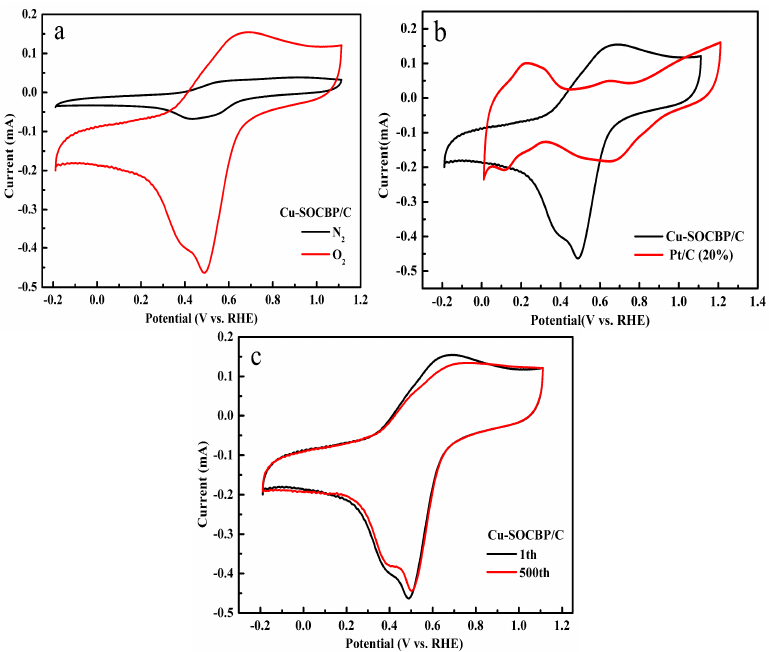
Figure 5. Cyclic voltammetry (CV) of Cu ‐ SOCBP/C in phosphate buffer solution (PBS) saturated once with N 2 and once with O 2 ( a ); CV of Cu ‐ SOCBP/C and Pt/C in PBS saturated with O 2 ( b ); and CV of Cu ‐ SOCBP/C in PBS saturated with O 2 ( c ). Scan rate: 100 mV/s.